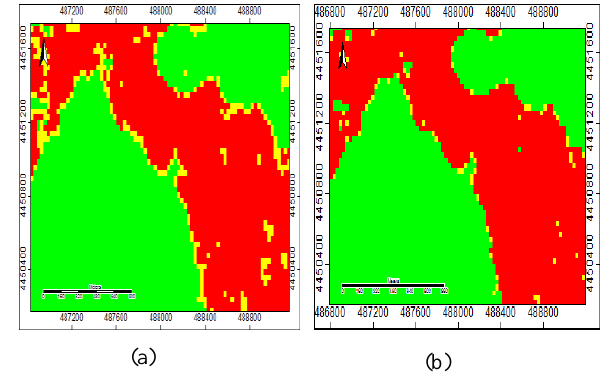
Figure 7. Changes in intensity of fire FLS (a) and SVM (b)